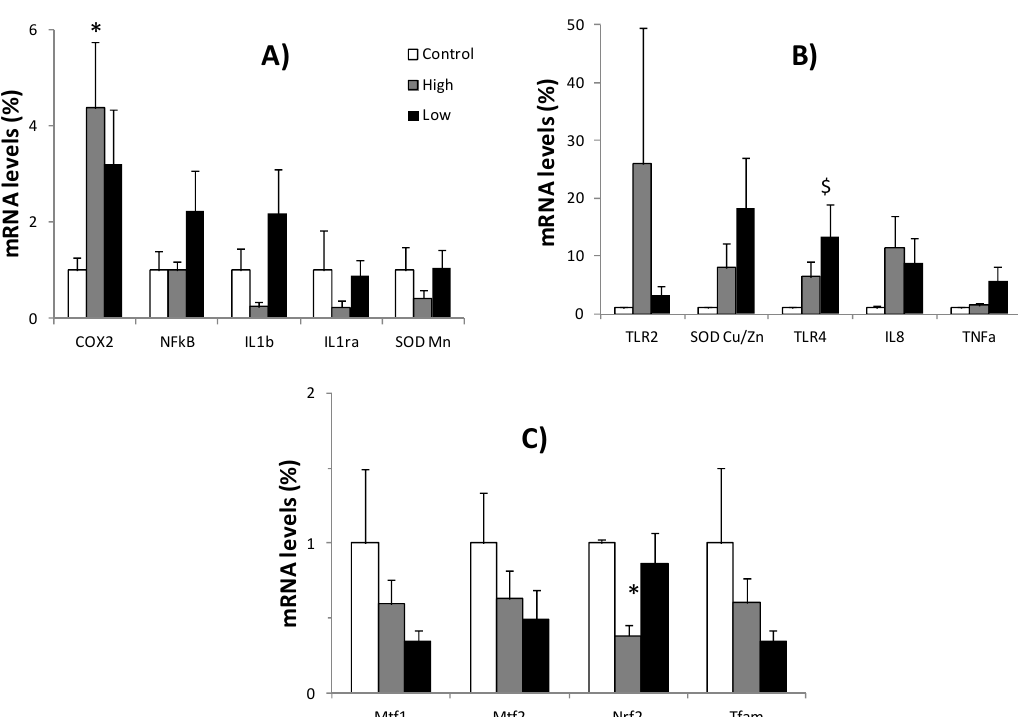
Figure 5. Relative expression of pro/anti-inflammatory proteins, antioxidant enzymes ( A , B ), and mitochondrial dynamics related proteins ( C ) in neutrophils Ribosomal 18S as a reference (Control: Only cells present in the medium; High: 15 μg solid GOX/mL; Low: 5 μg solid GOX/mL). Statistical analysis: Student’s t-test for paired data, p < 0.05. (*)Significant effects between the high treatment and the control; ($) significant effects between the low treatment and the control.